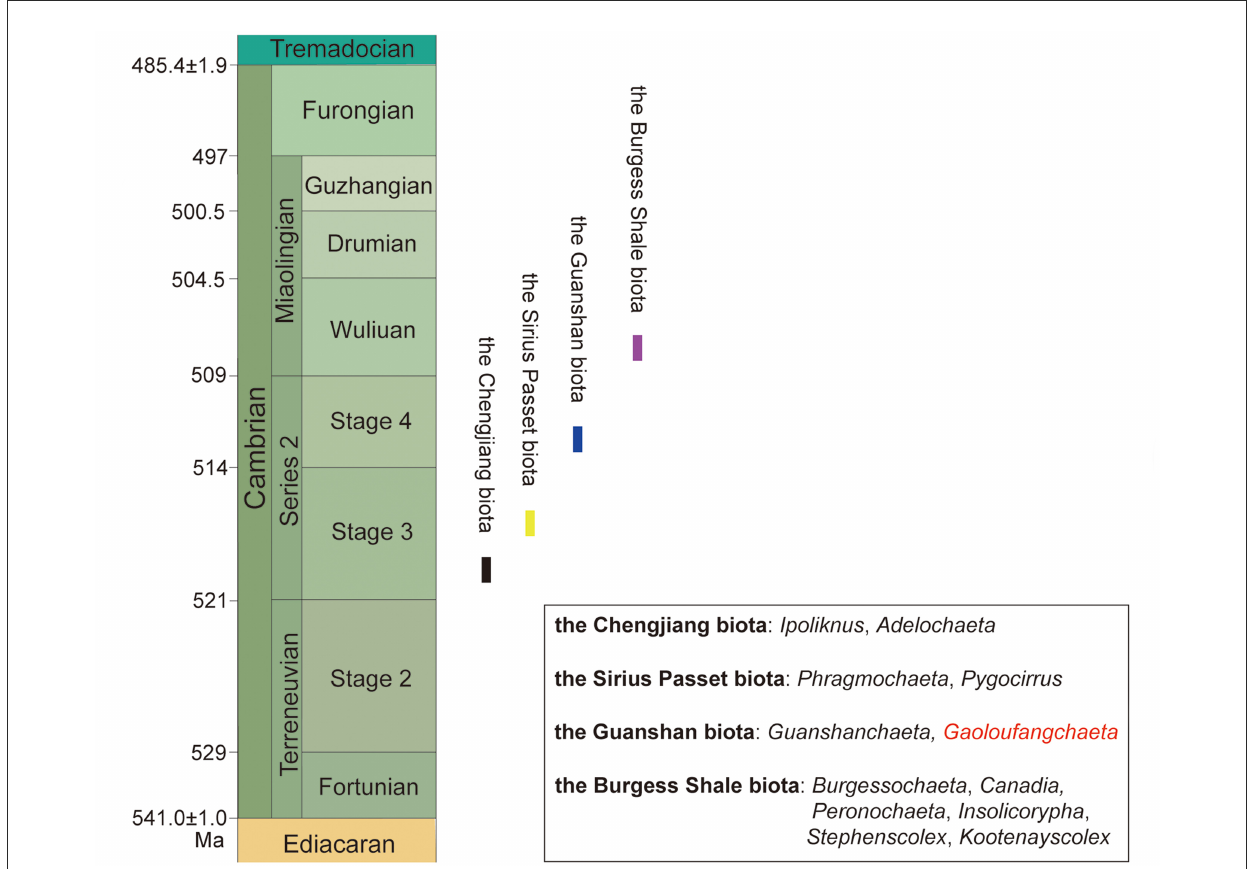
FIGURE5 Main early and middle Cambrian fossil Lagerstätten yielding polychaetes.